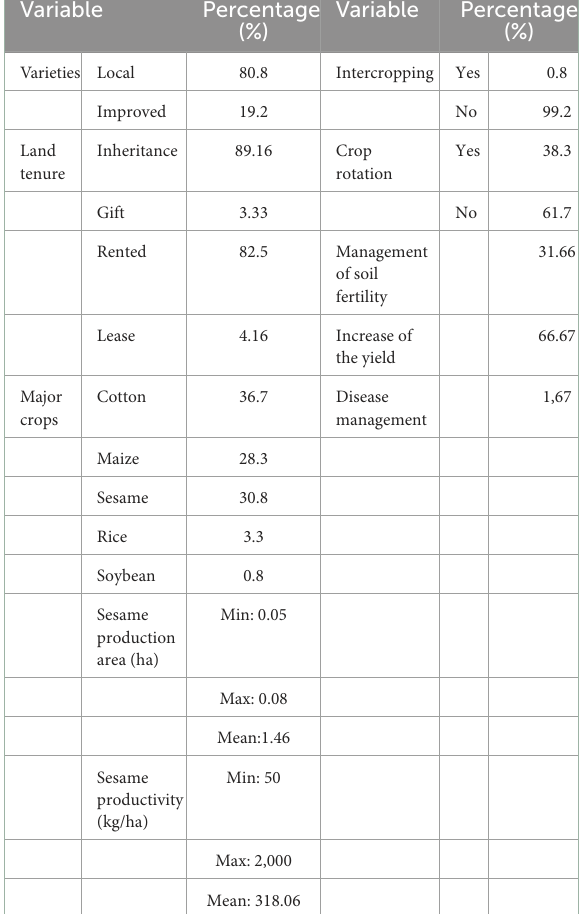
TABLE 3 Distribution of the respondents based on varieties, land tenure, major crops, intercropping, crop rotation, crop management. Variable